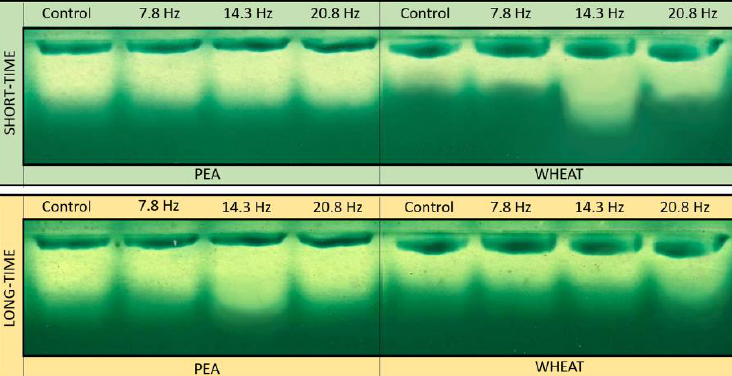
Figure 2. Enzyme activity patterns of catalase in extracts from wheat and pea leaves after ELF EMF influence. EMF